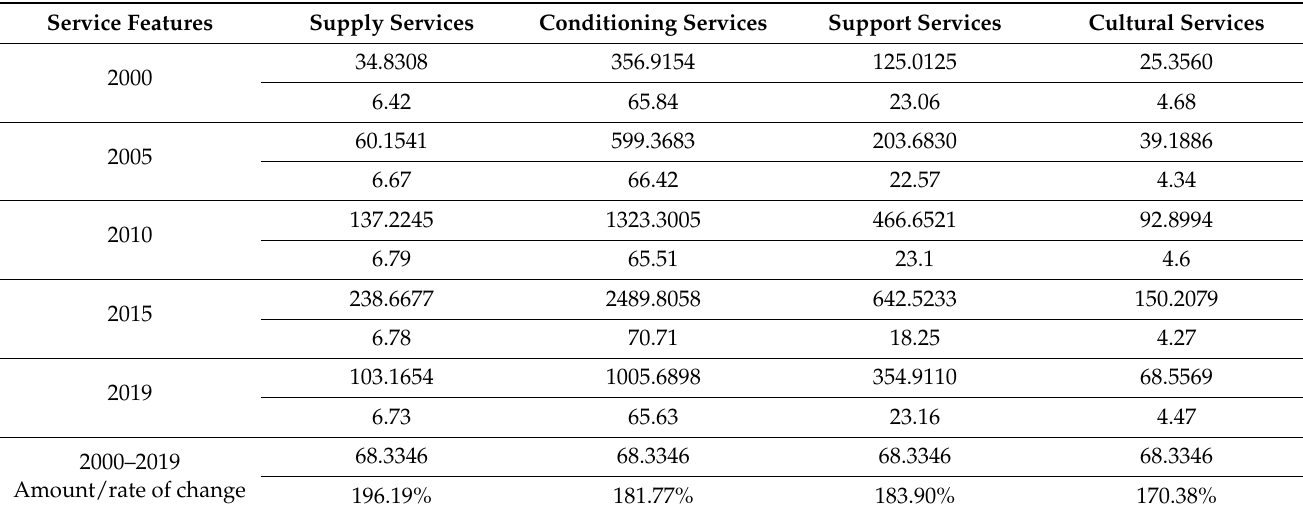
Table 7. Total value and proportion of ecosystem services by land type in Qilian Mountain National Park (Gansu Area) and the corresponding changes (billion USD %).